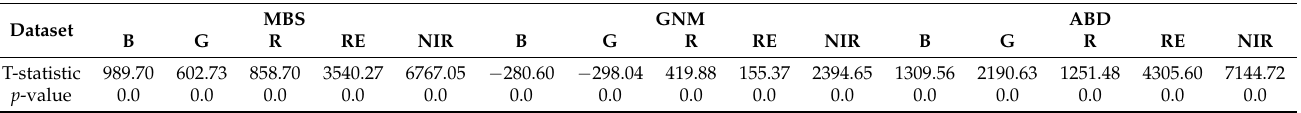
Table 3. Two-sample t-test results between each wavelength reflection distribution in the training and testing sets, including MBS, GNM, and ABD.